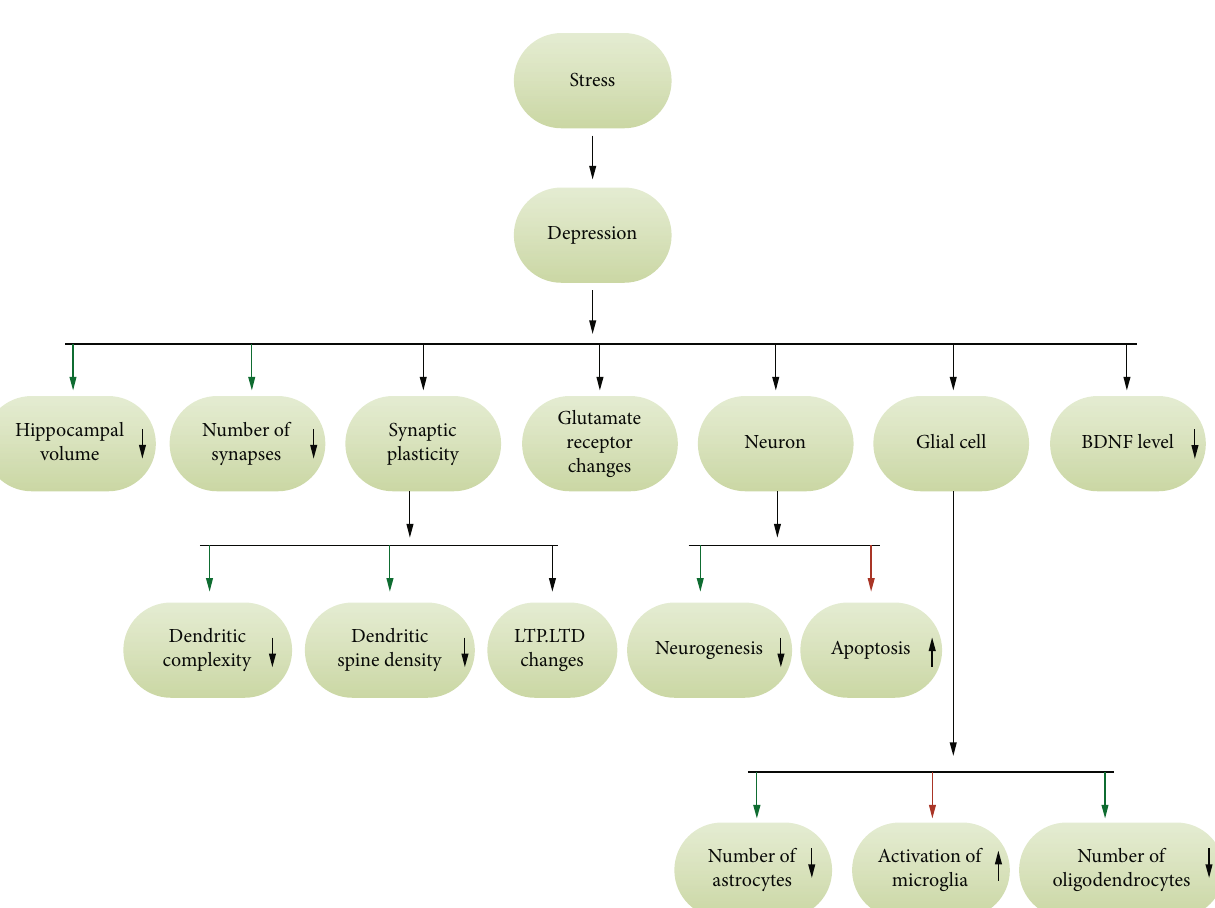
Figure 3: Changes in hippocampal plasticity in